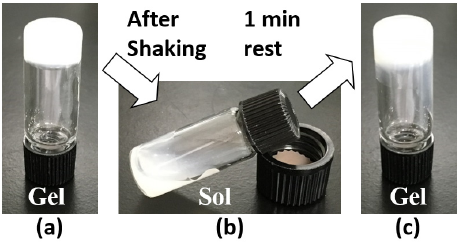
Figure 2. Thixotropic behavior of the organogel formed with C16H/C12H/C4H 1/1/1 (2 wt.%) squalane organogel: ( a ) organogel before shaking, ( b ) organosol after shaking, and ( c ) recovered organogel after 1 min rest of organosol.